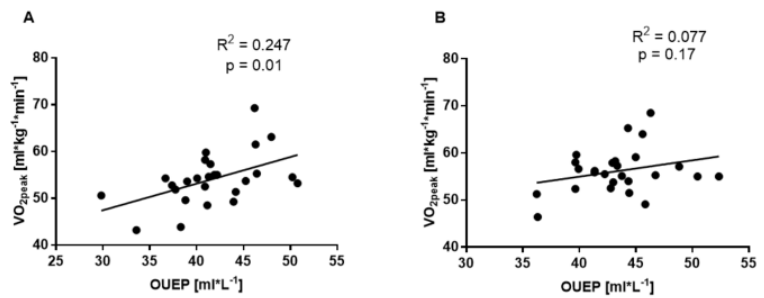
Figure 3. The linear relationship between VO 2peak and OUEP before ( A ) and after ( B ) twelve weeks of combined endurance training and supplementation (OMEGA and MCT groups; n = 26).